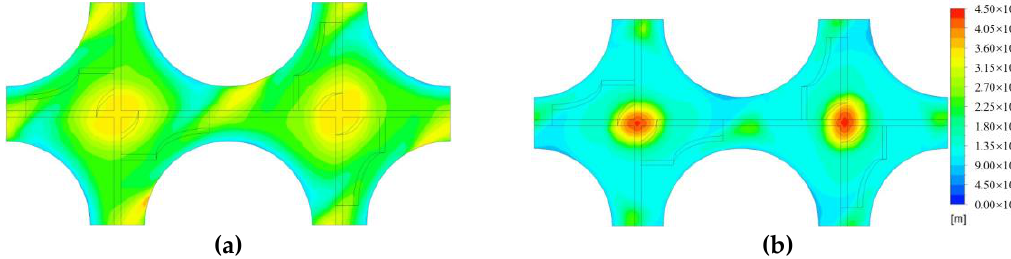
Figure 7. Bubble diameter at the plane 0.08 m downstream from spacer: ( a ) case 1, ( b ) case 4.